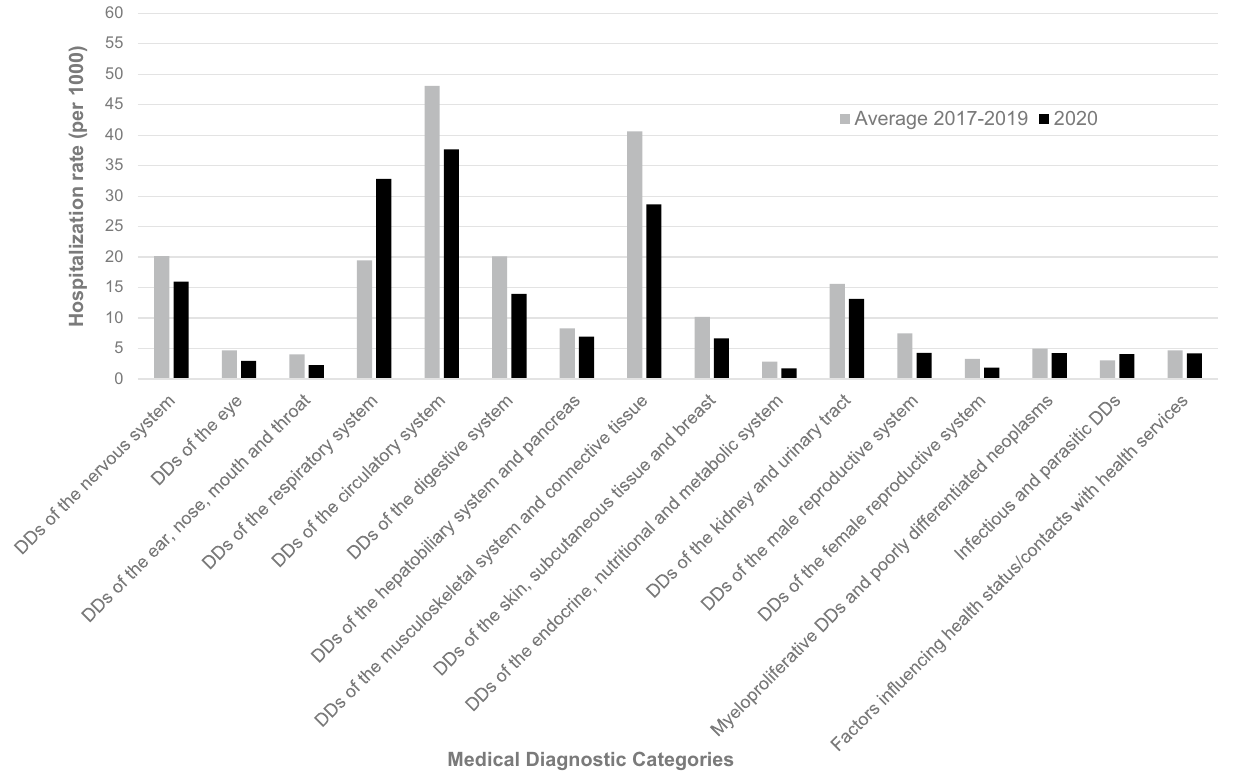
Figure 1. Hospitalization rates (per 1000) among individuals aged 65 years or more with a chronic disease from ATS Monza-Brianza and ATS Bergamo combined according to Major Diagnostic Categories in 2017–2019 and 2020. DD diseases and